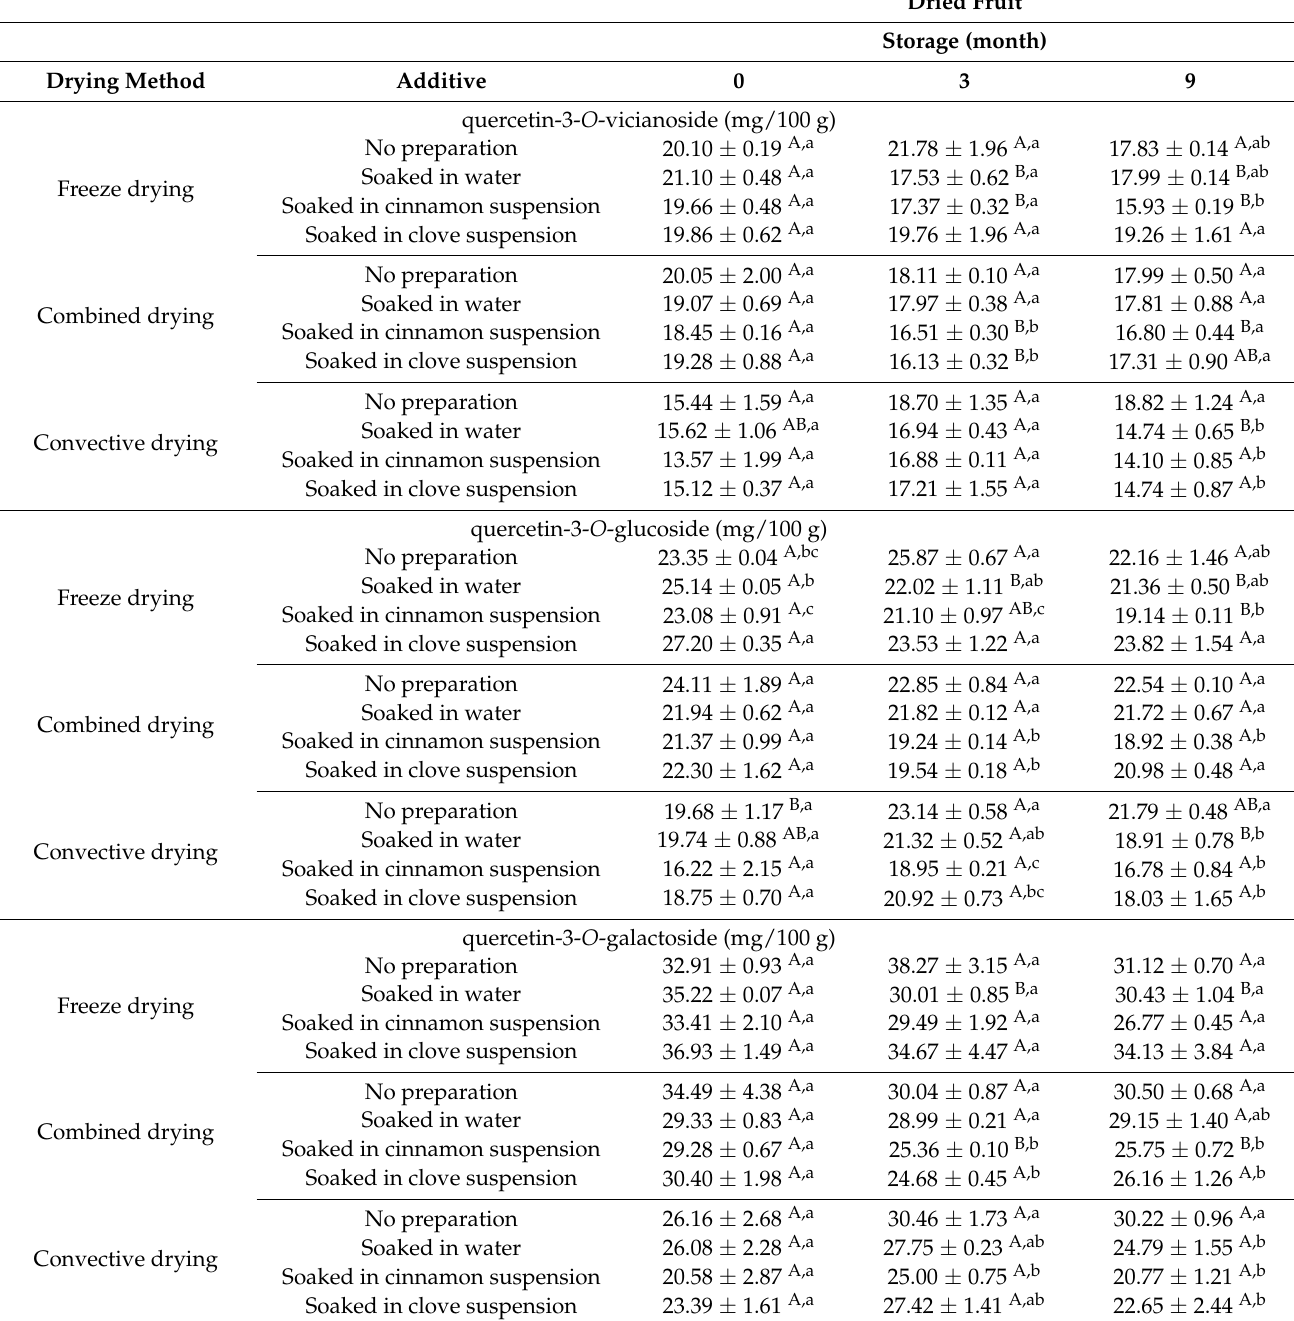
Table 4. Changes in flavonols content during storage of tested black chokeberry